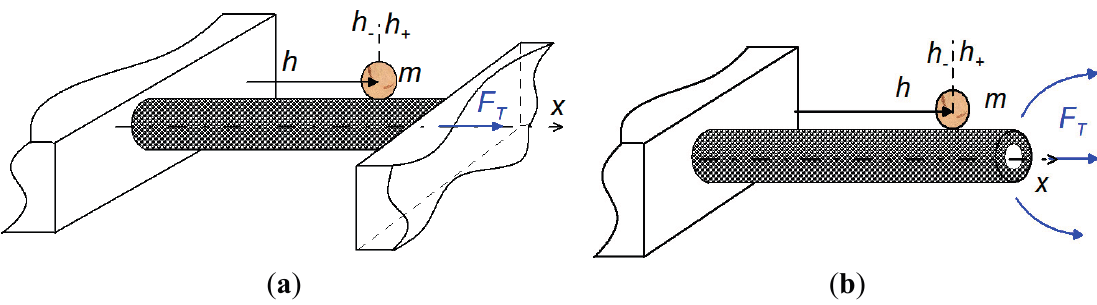
Figure 1. A schematic representation of the nanomechanical mass sensor under axial tensile force with an attached particle in ( a ) suspended and ( b ) cantilever